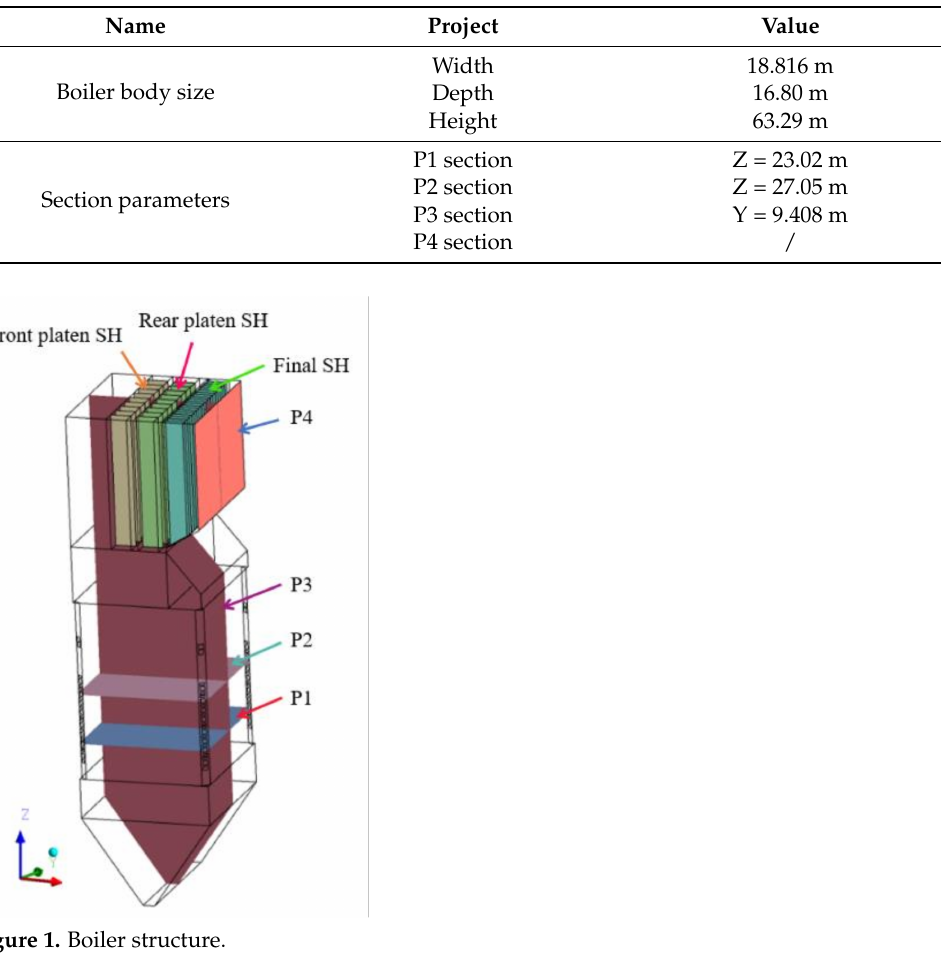
Table 1. Boiler body size and section parameters.